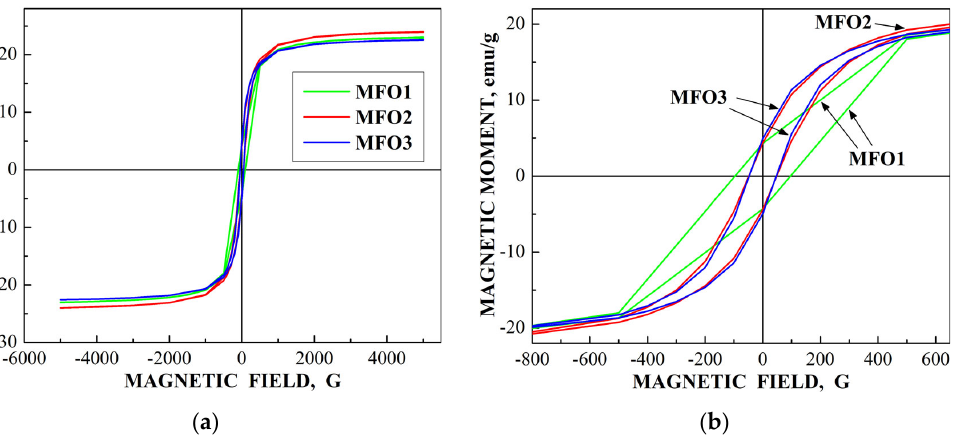
Figure 68. 295 K isothermal magnetization curves of MFO1, MFO2 and MFO3 nanosized particles ( a ) and enlarged part of these curves with the hysteresis loops ( b ). Adapted from Ref. [94] with permission from Elsevier: Journal of Alloys and Compounds, Vol. 912, Ushakov M.V., Nithya V.D.,